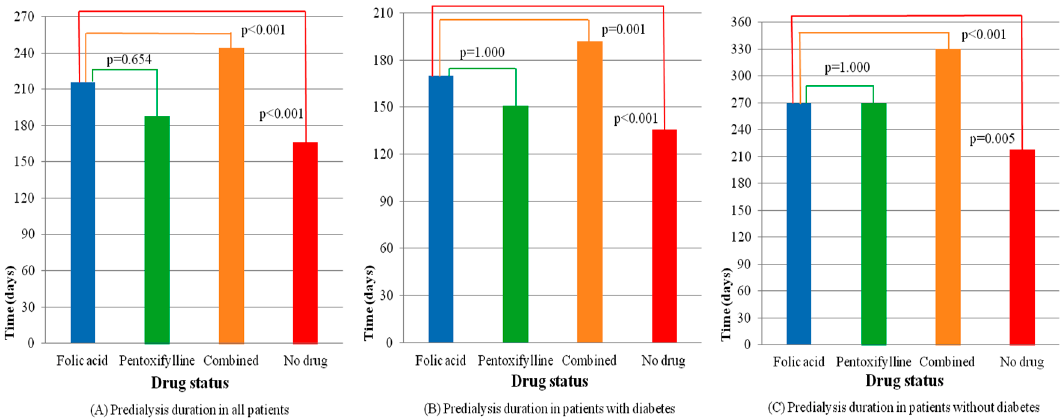
Figure 2. Comparisons of the predialysis duration among drug groups in patients with and without diabetes. ( A ) Predialysis duration in all patients, ( B ) Predialysis duration in patients with diabetes, ( C ) Predialysis duration in patients without diabetes.